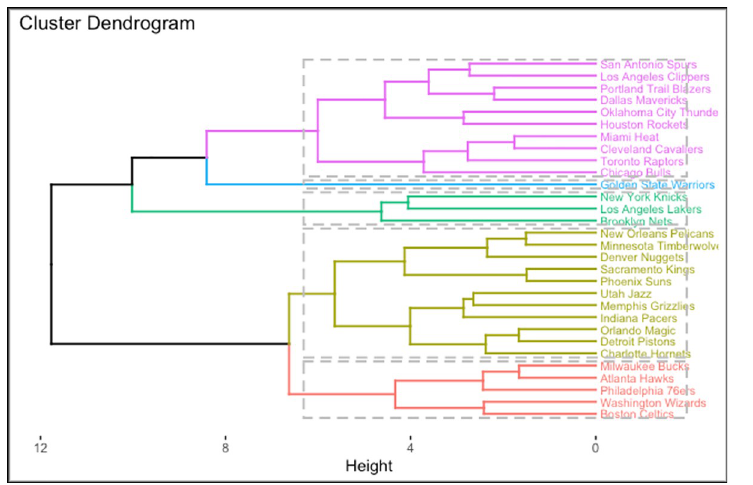
Fig 7. Plot of hierarchical